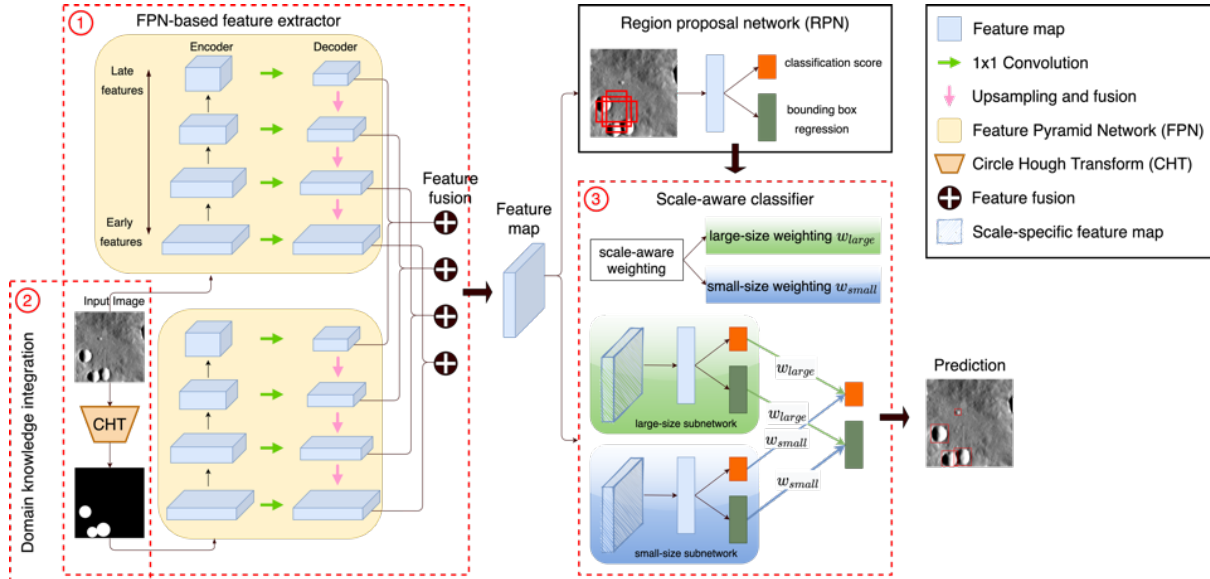
Figure 3. A knowledge-driven, scale-aware Mars crater detection pipeline. Components 1–3 in dashed boxes are new features of the